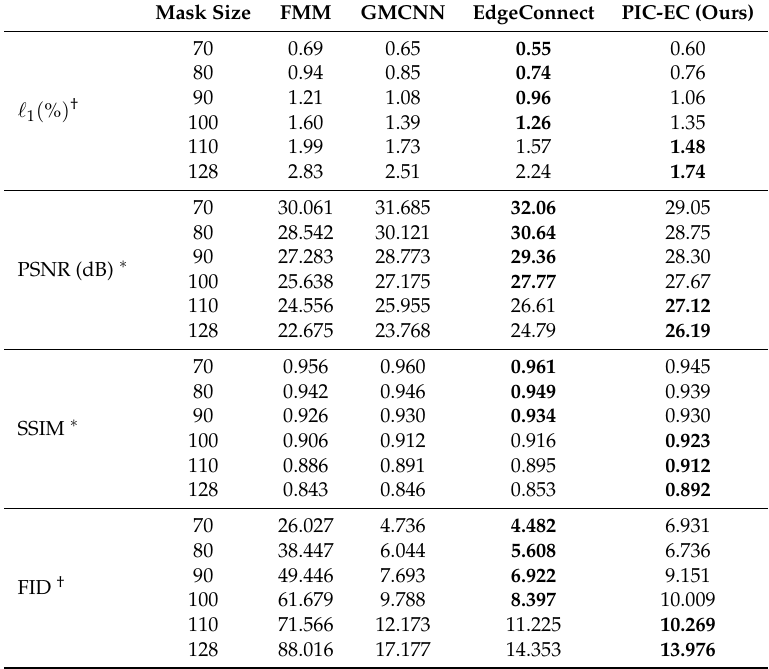
Figure 8. Effect of different masks over CelebA-HQ. ( a ) results of (cid:96) 1 metric; ( b ) results of PSNR (Peak Signal-to-Noise Ratio) metric; ( c ) results of SSIM (Structural Similarity Index Metric) metric; ( d ) results of FID (Fréchet Inception Distance) metric. Table 4. Quantitative results over the Paris StreetView for six different masks with methods: FMM, GMCNN, EdgeConnect and PIC-EC. Boldface in each row indicates the best performance. ∗ Higher is better. † Lower is